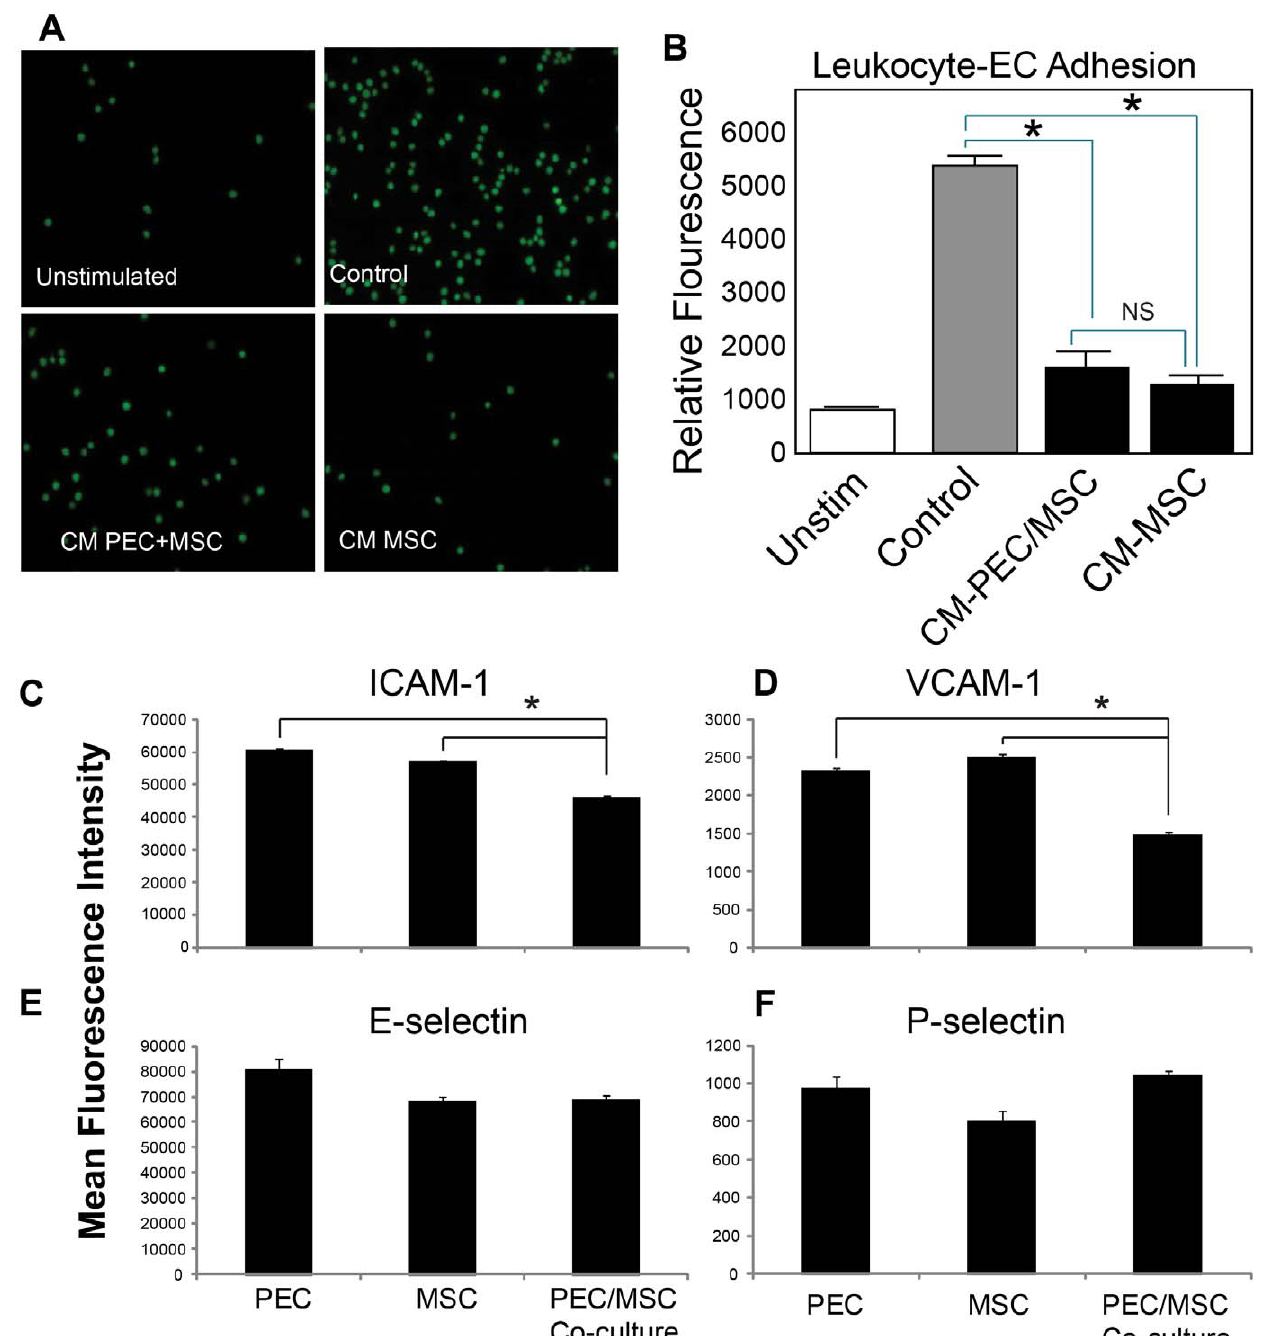
Figure 2. CM inhibits adhesion of U937s and adhesion molecule expression in PECs. Figures 2A and 2B, CM from MSC and MSC + PEC co- cultures inhibits adhesion of U937 to PECs. Calcein labeled U937 cells were allowed to adhere to PECs that had been pre-treated with CM from PEC and MSC-PEC co-cultures. Cultures were stimulated with TNF a and U937s were added to the wells. After gentle washing, bound cells were quantitatively and qualitatively assessed. Figure 2A shows decreased binding of U937 (green dots) in CM treated cultures. Figure 2B shows quantitative significant decreases in CM treated cultures as indicated by (*), which signifies p , 0.05 between control (TNF a treated cells) and MSC CM and control and CM-CO (MSC-PEC CM). ‘‘Unstim’’ represents the group not treated with TNF a . Eight wells were included in each group (n=8). Figures 2C–F, CM from MSC + PEC co-cultures inhibits PECs expression of adhesion molecules VCAM-1 and ICAM-1. Conditioned media was made in three groups: (1) PECs alone, (2) MSCs alone, (3) PECs/MSCs co-culture. EGM-2 (Lonza) was added to wells as culture medium. After 48 hours of culture the media was removed and stored at 2 80 u C. PECs grown to confluence on 6 well plates and growth media was replaced with the conditioned media in the above groups. The experiment was performed in replicates of four. After 12 hour incubation, TNF a (50 ng/mL) was added to the wells and incubated for 4 hours. The cells were then collected and stained with fluorophore conjugated antibodies to I-CAM, V-CAM, E- selectin, and P-selectin. The cells treated with PEC/MSC conditioned media demonstrated decreased I-CAM and V-CAM expression compared to both those treated with PEC or MSC conditioned media(p , 0.01, ANOVA). This difference was not seen in E-selectin or P-selectin. doi:10.1371/journal.pone.0025171.g002 PLoS ONE |